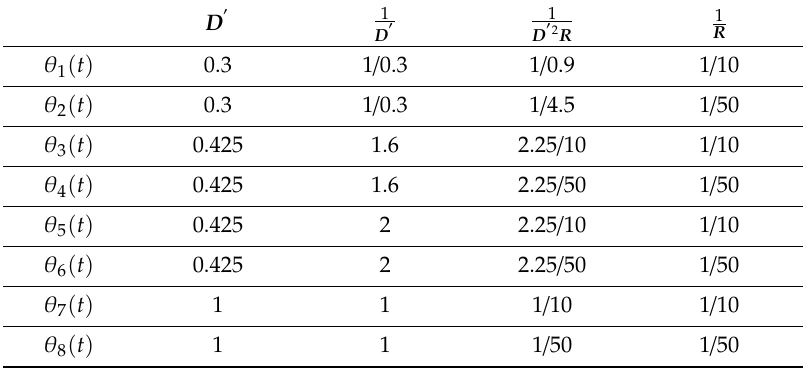
Figure 3. Plot of nonlinear uncertainty function (f(D’)) (solid line) and reduced polytope P 2011 (dashed line), as in [25]. The projections of the polytope are also shown in each respective plane. Table 1. Vertices of the polytopic covering of P 2011